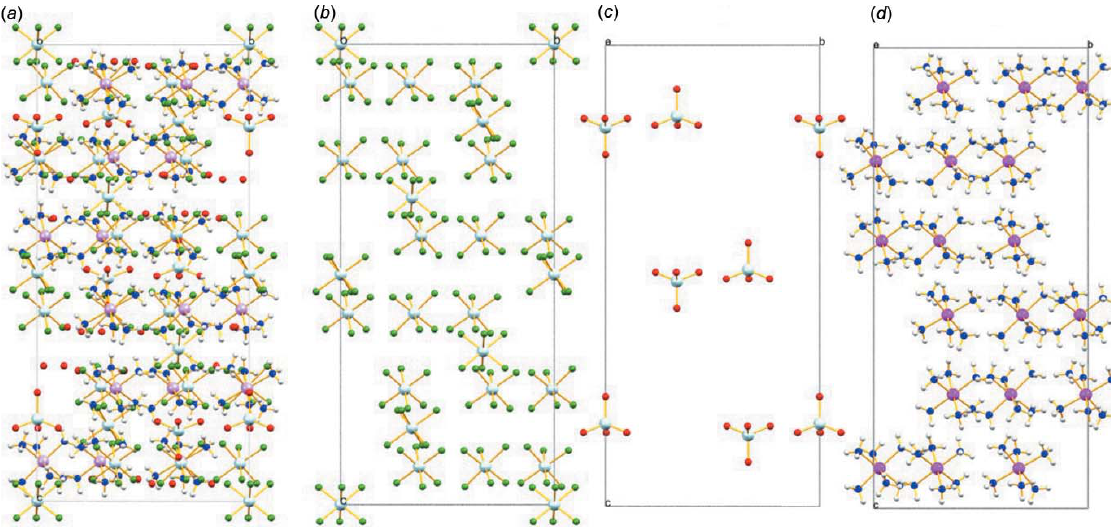
(cid:3) x + y , 5 (cid:3) z ; (iv) 1 + y , 2 + x (cid:3) y 3 3 3 3